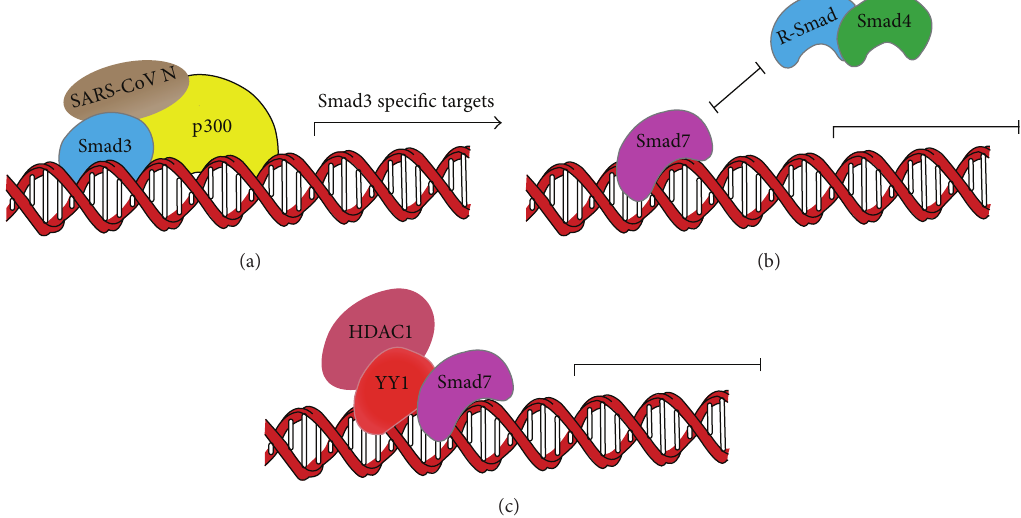
Figure 4: Regulation of Smad activity in the nucleus. (a) SARS-CoV N protein interacts with Smad3 and enhances the Smad3-p300 interaction, potentiating the Smad3-mediated transcription of fibrotic genes. SARS-CoV N protein can also interfere with the complex formation between Smad3 and Smad4, thereby inhibiting Smad4-mediated expression of apoptotic genes. (b) Smad7 directly binds to DNA and represses TGF- 𝛽 signaling by interfering with the functional R-Smad/Smad4-DNA complex on target gene promoters. (c) YY1 can cooperate with Smad7 to inhibit TGF- 𝛽 signaling in the nucleus via recruiting